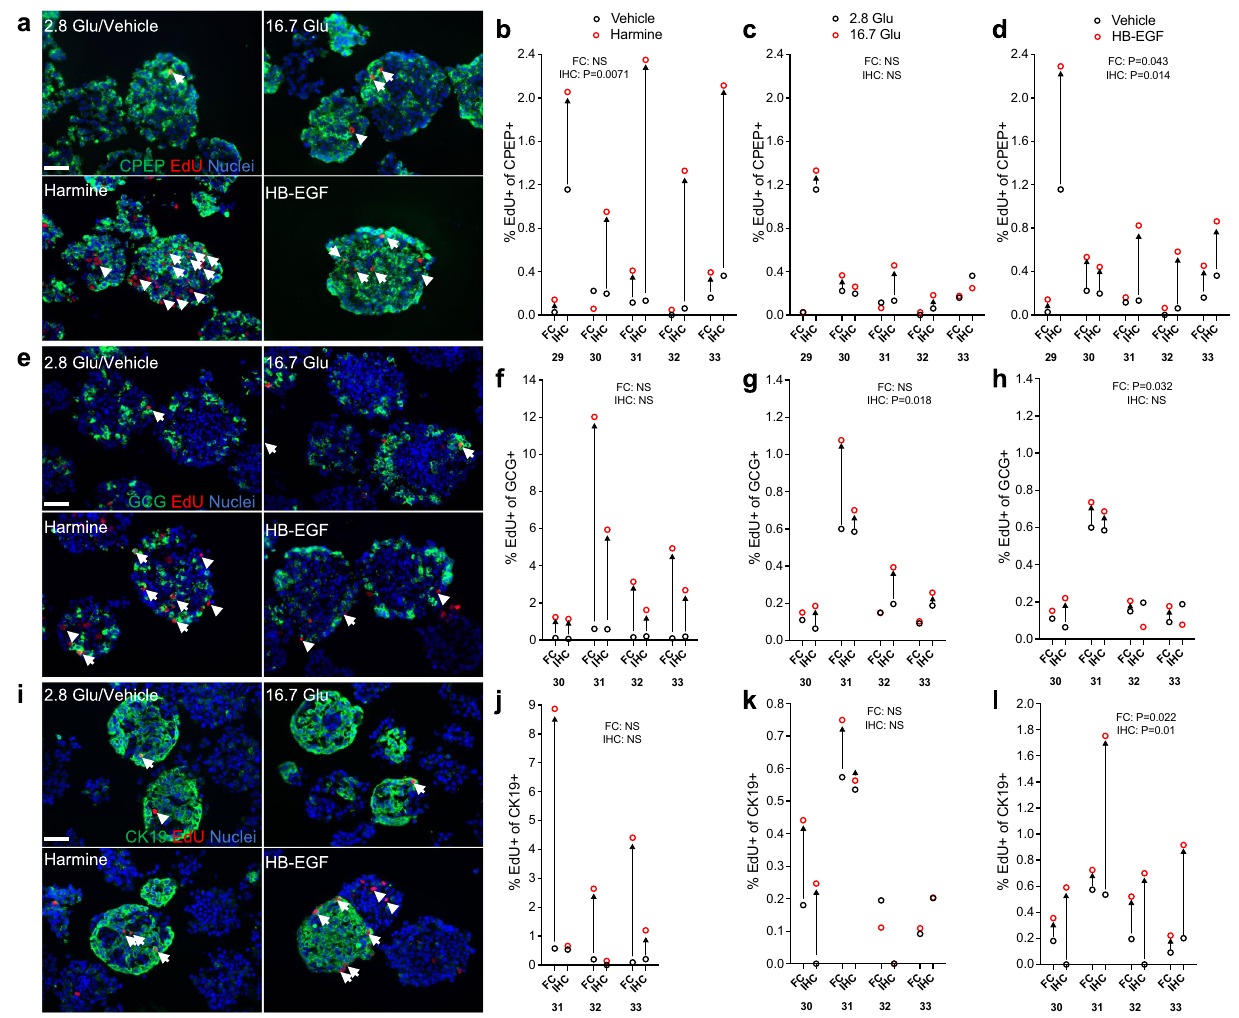
Figure 7. Comparison of immunohistochemistry and flow cytometry to assess human islet cell proliferation. ( a – l ) Intact human islets were exposed to 2.8 mM glucose (Vehicle or 2.8 Glu; a – l ), harmine (10 μM) ( a , b , e , f , i , j ), 16.7 mM glucose (16.7 Glu; a , c , e , g , i , k ) and HB-EGF (100 ng/ml) ( a , d , e , h , i , l ) for 72 h. EdU (10 μM) was added throughout. Proliferation was assessed in parallel for each donor by immunohistochemistry (IHC) and flow cytometry (FC) following staining for C-peptide (CPEP), glucagon (GCG), cytokeratin 19 (CK19) and EdU. ( a , e , i ) Representative images of CPEP ( a , green), GCG ( e , green), CK19 ( i , green), EdU (red) and nuclei (blue) staining are shown. Arrows and arrowheads highlight respectively, EdU + /CPEP + and EdU + /CPEP − ( a ), EdU + / GCG + and EdU + /GCG − ( e ) and EdU + /CK19 + and EdU + /CK19 − ( i ). Scale bar, 50 μm. Images were acquired using an Axio Imager with ZEN 2012 software (https:// www. zeiss. com/ micro scopy/ int/ produ cts/ micro scope- softw are/ zen. html). A minimum of 1000 and 2000 CPEP + , GCG + and CK19 + cells were counted for each sample in immunohistochemistry and flow cytometry, respectively. Proliferation is presented as the percentage of EdU + cells over the total cells for each of CPEP + ( a – d ), GCG + ( e – h ) and CK19 + ( i – l ) cell types. Graphs showing cell proliferation of individual donors were generated using GraphPad Prism 9 software (https:// www. graph pad. com/ scien tific- softw are/ prism/). Donor identifiers (Supplementary Table S1 online) are indicated. Significance was tested using paired t tests (b-d,f-h,j-k). P < 0.05 was considered significant. NS, not